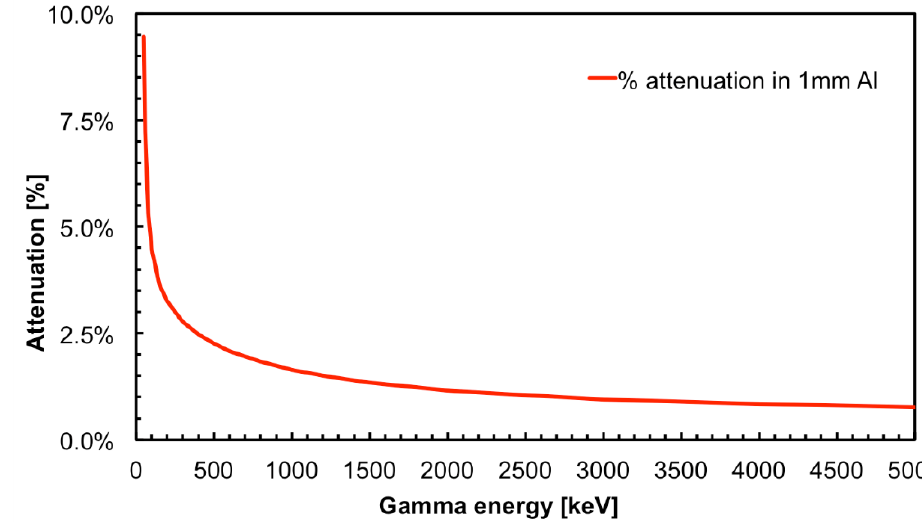
Figure 9. Attenuation of gamma-rays in 1 mm aluminum as a function of the energy [15].